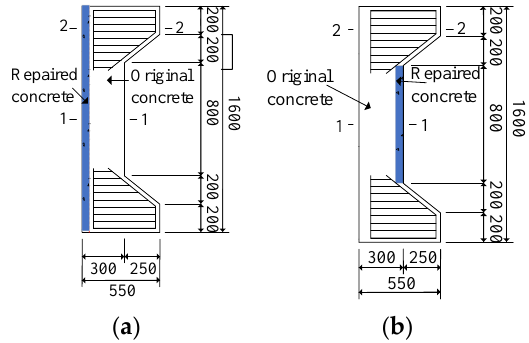
Figure 4. Design of reinforced specimen (Unit: mm). ( a ) Tensile side reinforcement specimen; ( b ) Compression side reinforcement specimen.